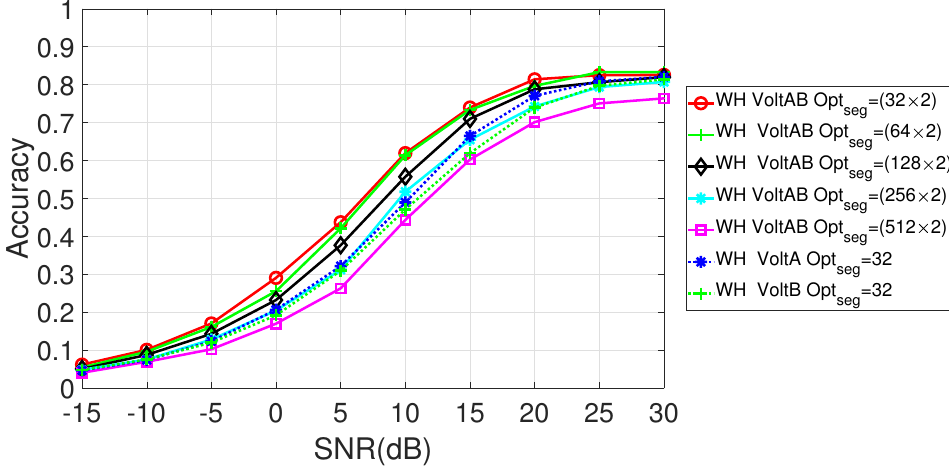
Figure 4. Accuracy trends with CNN and WHT with different values of Opt seg and for different values of SNR in dB. When both voltage signals are used, Opt s eg is indicated as multiplied by 2 in the